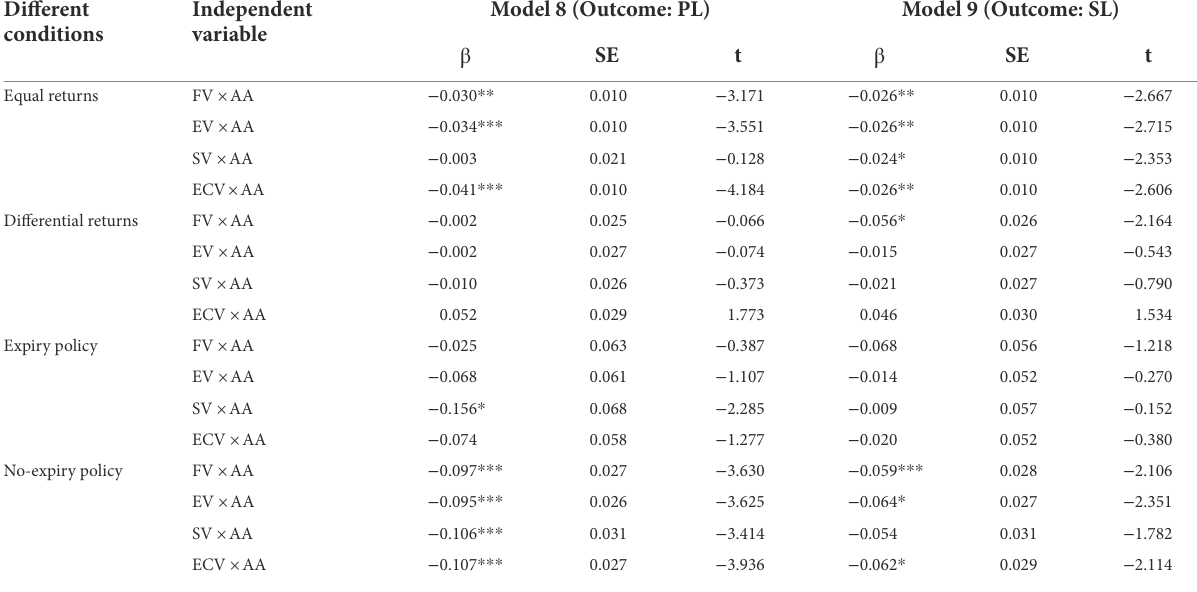
TABLE 12 Moderation effect of alternative attractiveness under different